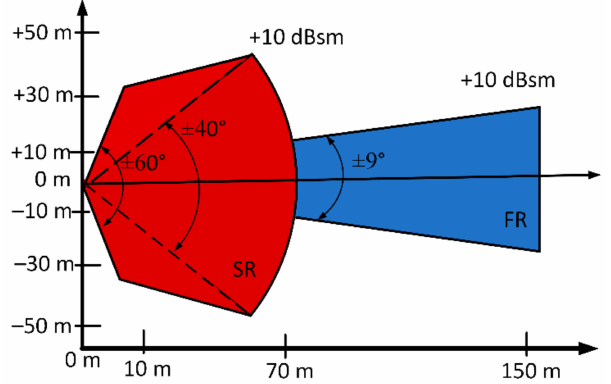
Figure 1. Radar FoV. Table 1. Technical characteristics of the radar sensors (the azimuth angle is measured on a plane parallel to the building facade whereas the elevation angle is measured on a plane perpendicular to the building